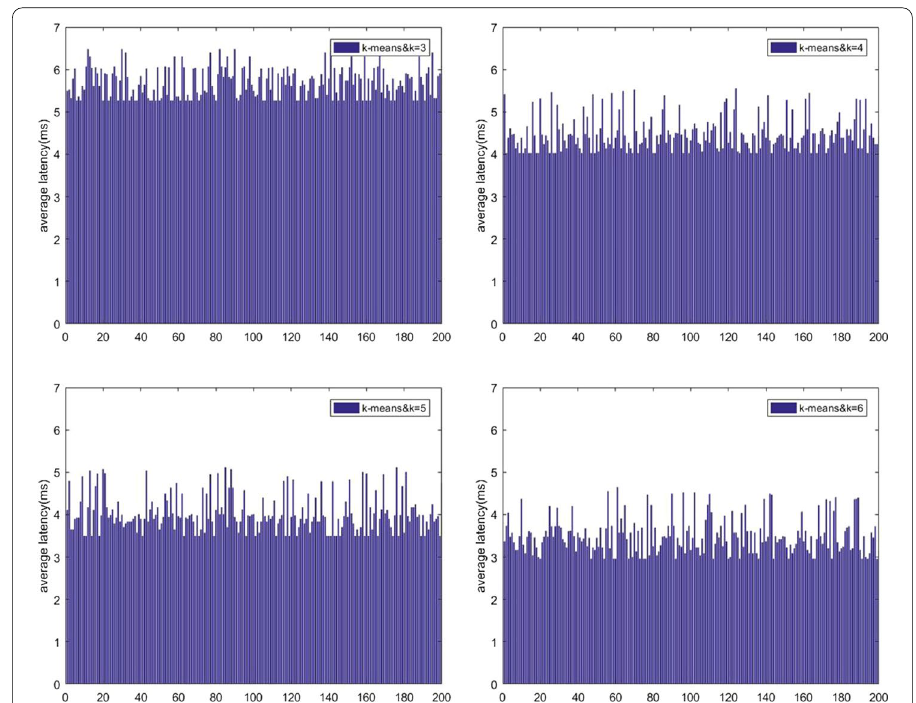
Fig. 4 The average latency obtained by the standard K-means algorithm 200 times (Internet2 OS3E). x axis: test times: According to the k-means algorithm, we calculated the deployment positions of controllers 200 times when the number of controllers is 3, 4, 5 and 6. y axis: average latency